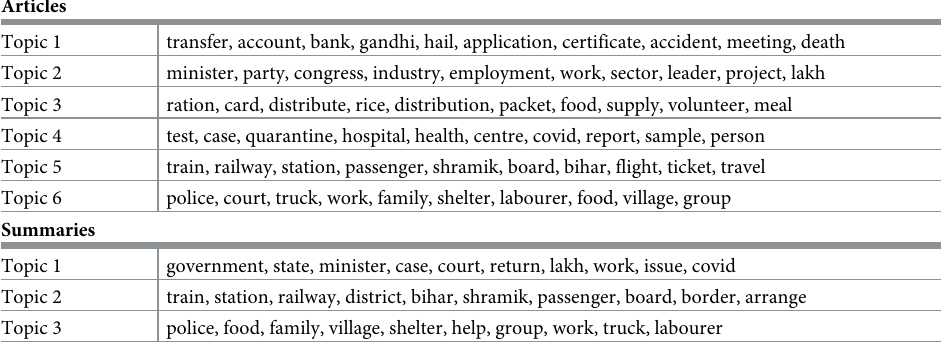
Table 2. Illustrating the words describing various topics identified using TF-IDF model for both article text and